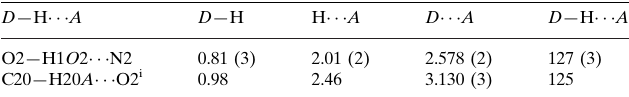
Hydrogen-bond geometry (A˚ , (cid:2)